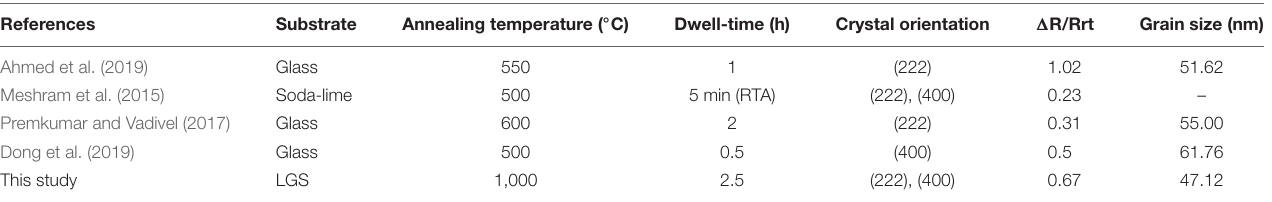
FIGURE 9 | XPS spectra in the O1s (A) , Sn 4 + and Sn 2 + (B) region for the ITO films annealed at 1,000 ◦ C for 1 h. TABLE 3 | Comparison of conductive ITO films at high